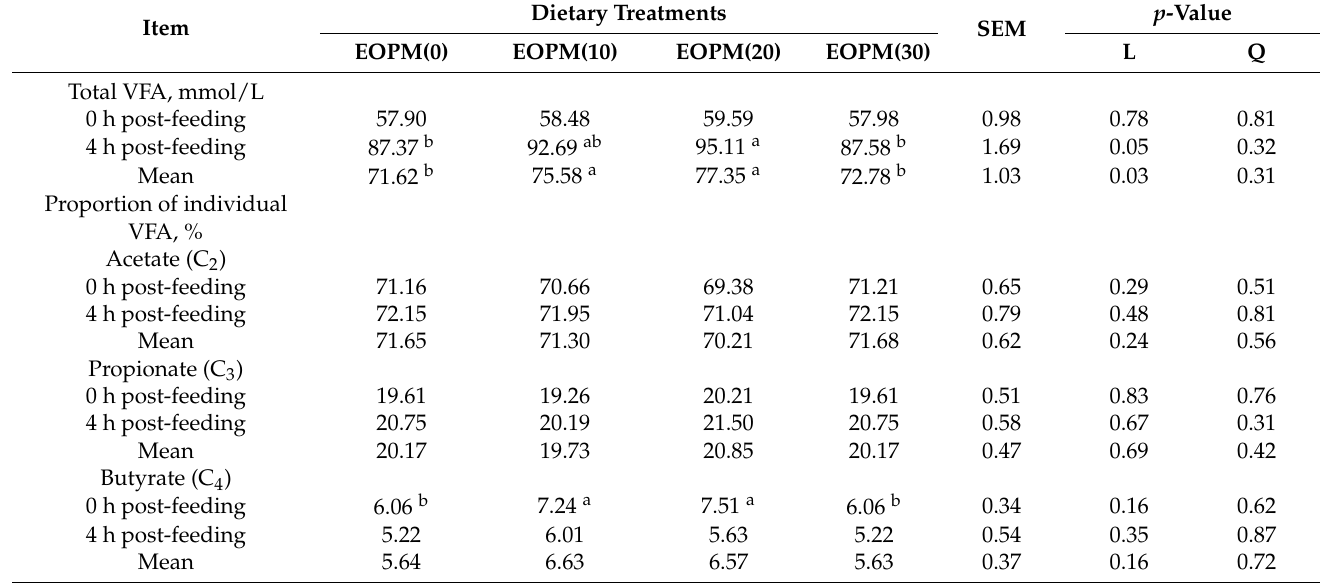
Table 6. Volatile fatty acid profiles in goats fed TMR diets containing extracted oil palm meal